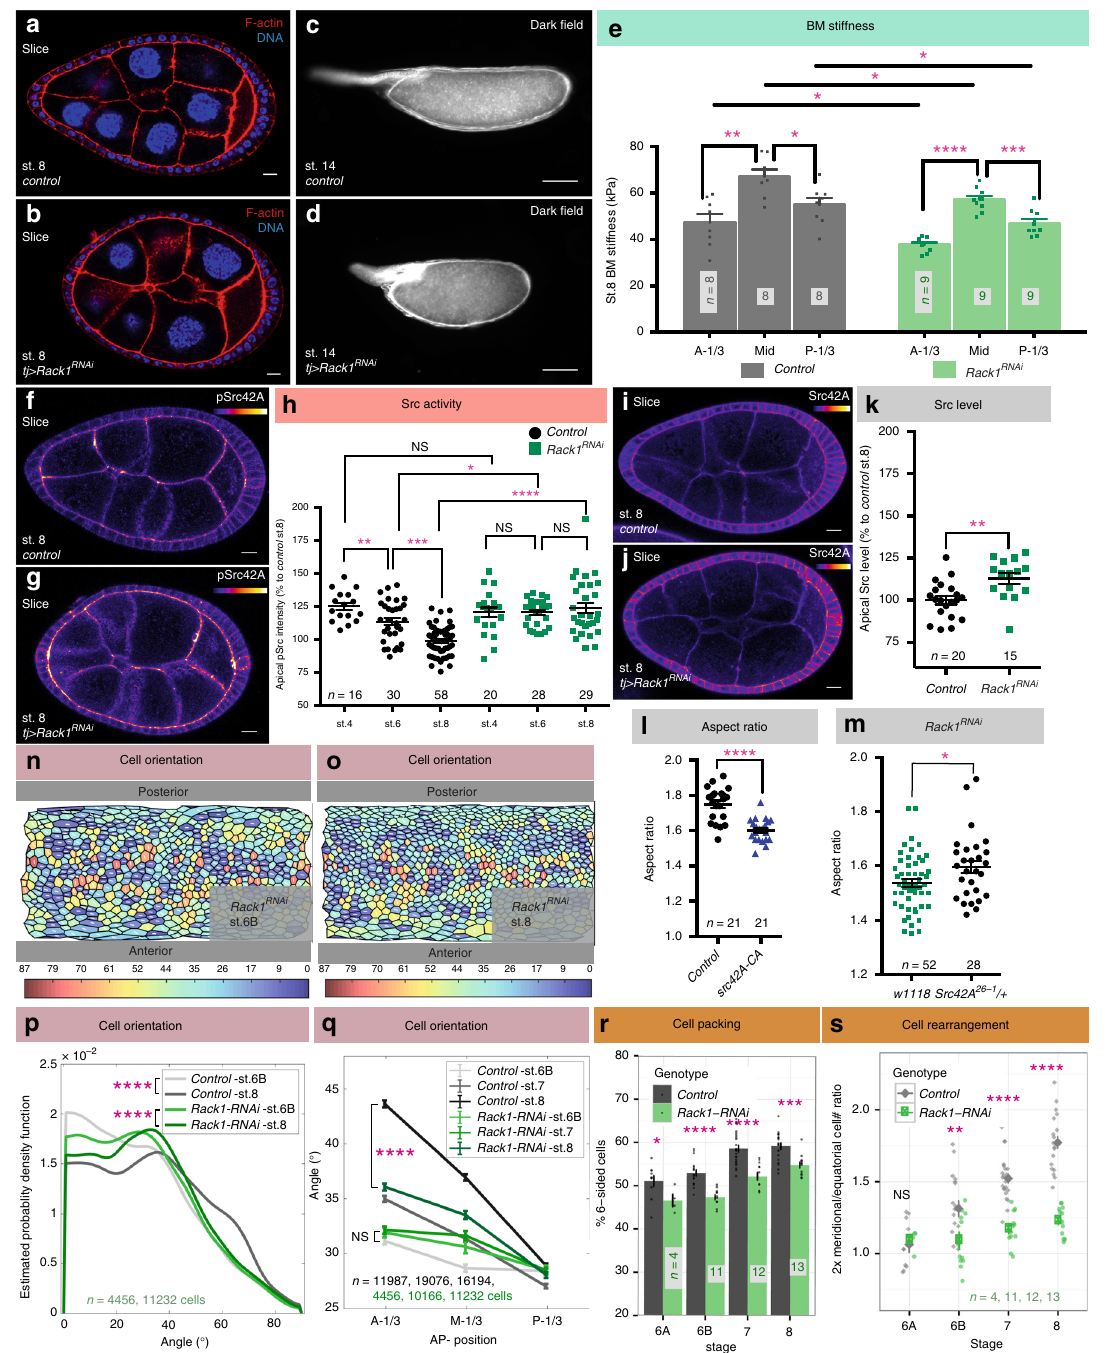
Fig. 6e). Consistent with the model, RNAi-mediated depletion of Rack1 via 10XSTAT-GAL4 was suf fi cient to generate elongation defects, with a severity comparable to depletion throughout the follicle epithelium (Fig. 7k, l). Overexpression of active Src42 with this anterior driver also was suf fi cient to generate elongation defects (Fig. 7l). Together, these data indicate that differences in the mechanical status of the BM, signaled via Src, regulate anterior cell reorientation to allow tissue elongation. of biology, as quantitative tools and model systems allow